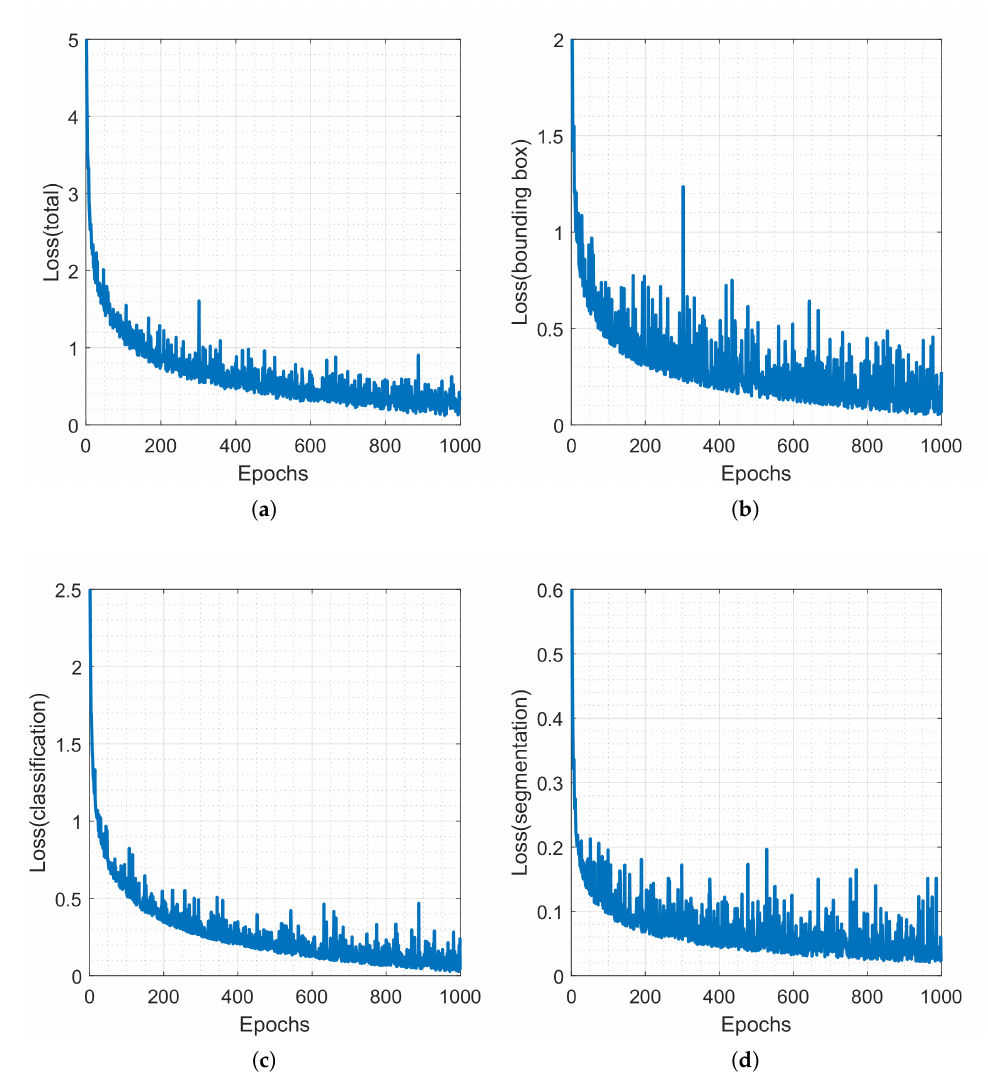
Figure 10. ( a ) Total loss; ( b ) bounding box loss; ( c ) classification loss; ( d ) segmentation